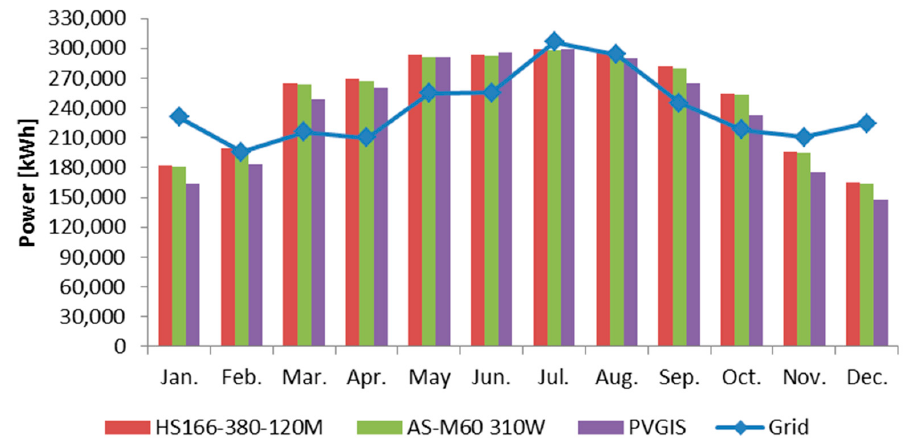
Figure 8. Azimuth and tilt angle impact on ( a ) annual average daily solar radiations, ( b ) annual average solar radiations, ( c ) output power of PV system, ( d ) capacity factor (CF), and ( e ) annual GHG emission reduction.